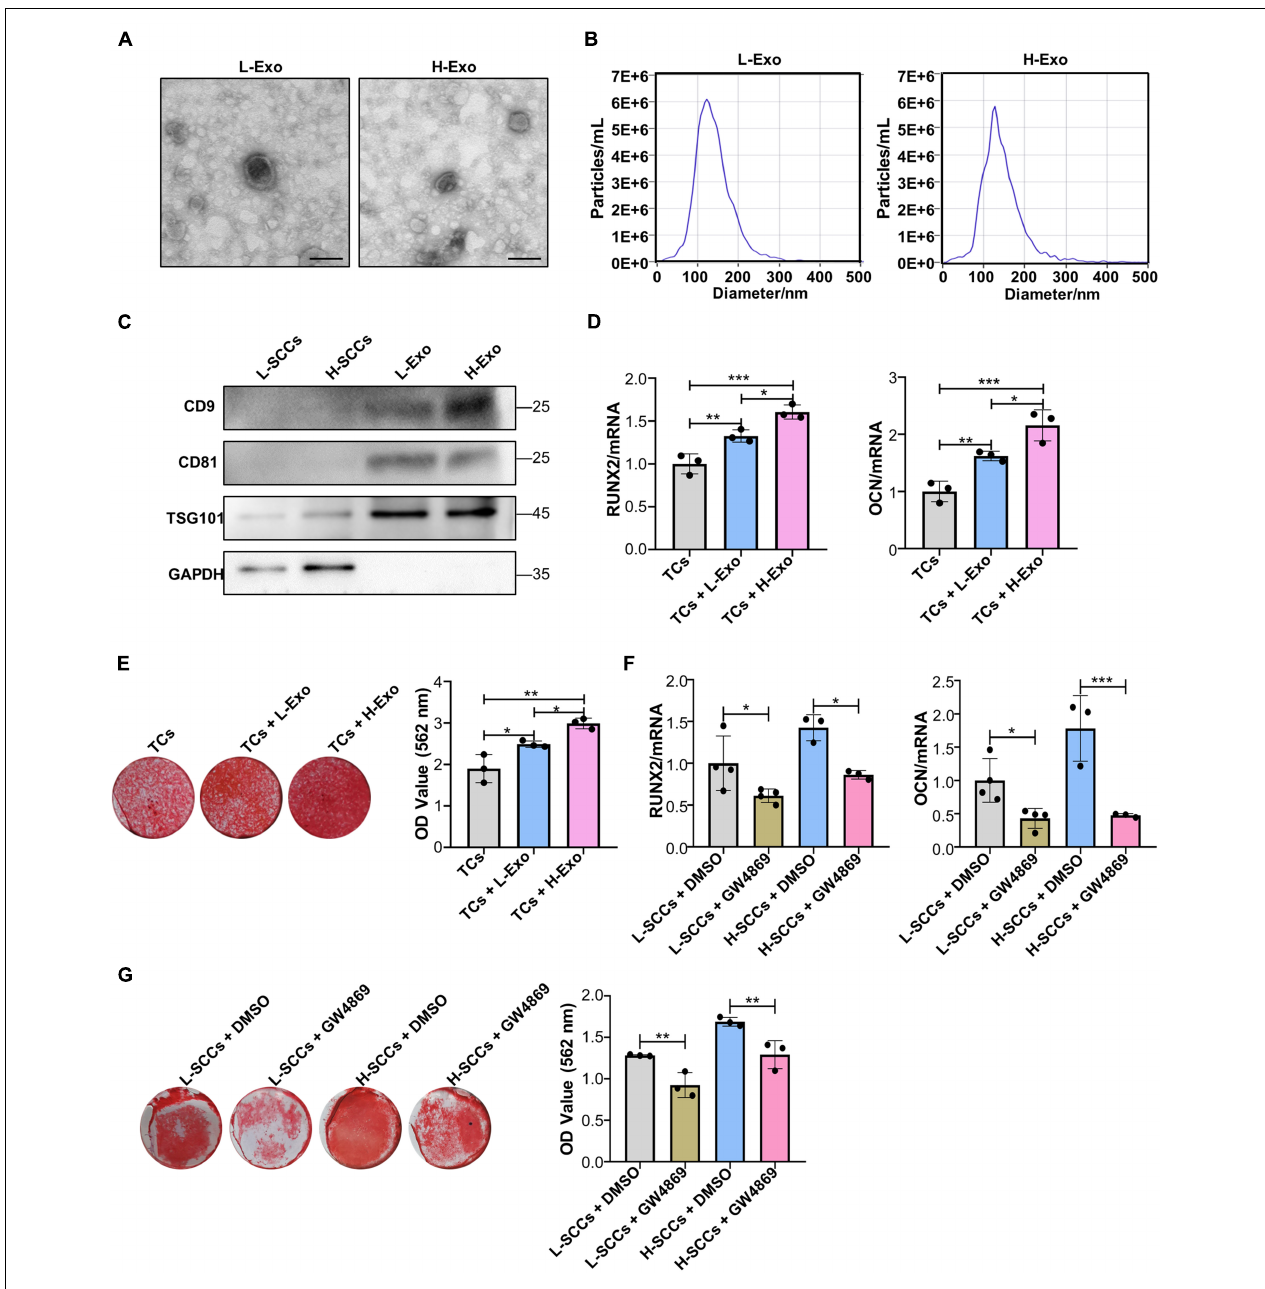
FIGURE 2 | H-Exo were superior to L-Exo in promoting osteogenic differentiation in the TCs. (A) Exosomes obtained from H-SCCs and L-SCCs were identified by TEM. (B) Size distribution was assessed using a ZetaView nanoparticle tracking analyzer. (C) The expression of the exosomal marker proteins CD9, CD81, and TSG101 was tested by western blot. (D) Osteogenic inducing fluid containing 20 µ g/ml exosomes was used, and the expression of the osteogenic differentiation-related genes in unstimulated TCs, or TCs stimulated by L-Exo or H-Exo, was measured by RT-qPCR after 7 days of osteogenic induction ( n = 3). (E) Osteogenic inducing fluid containing 20 µ g/ml exosomes was used, and Alizarin red staining of unstimulated TCs, or TCs stimulated by L-Exo or H-Exo, was performed after 28 days of osteogenic induction ( n = 3). (F) The collected supernatants from the culture of DMSO- or GW4869-treated SCCs were mixed with equal volumes of twofold concentrated osteogenic induction medium to stimulate the TCs, and the expression levels of the osteogenic differentiation-related genes in the TCs were determined by RT-qPCR after 7 days of osteogenic induction ( n = 3 or 4). (G) The collected supernatants from the culture of DMSO- or GW4869-treated SCCs were mixed with equal volumes of twofold concentrated osteogenic induction medium to stimulate the TCs, and Alizarin red staining of the TCs was performed after 28 days of osteogenic induction ( n = 3). L-Exo, exosomes secreted by L-SCCs; L-SCCs + DMSO, TCs stimulated by the culture of DMSO-treated L-SCCs; L-SCCs + GW4869, TCs stimulated by the culture of GW4869-treated L-SCCs; H-Exo, exosomes secreted by H-SCCs; H-SCCs + DMSO, TCs stimulated by the culture of DMSO-treated H-SCCs; H-SCCs + GW4869, TCs stimulated by the culture of GW4869-treated H-SCCs; TCs, target cells; TEM, transmission electron microscopy. Scale bar, 100 nm. * P < 0.05; ** P < 0.01; *** P <